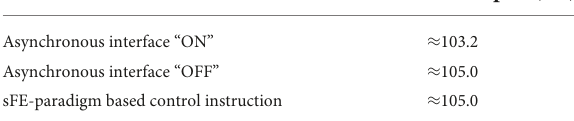
TABLE 15 Theoretical timespan for instruction generation. Instruction Theoretical timespan (ms)